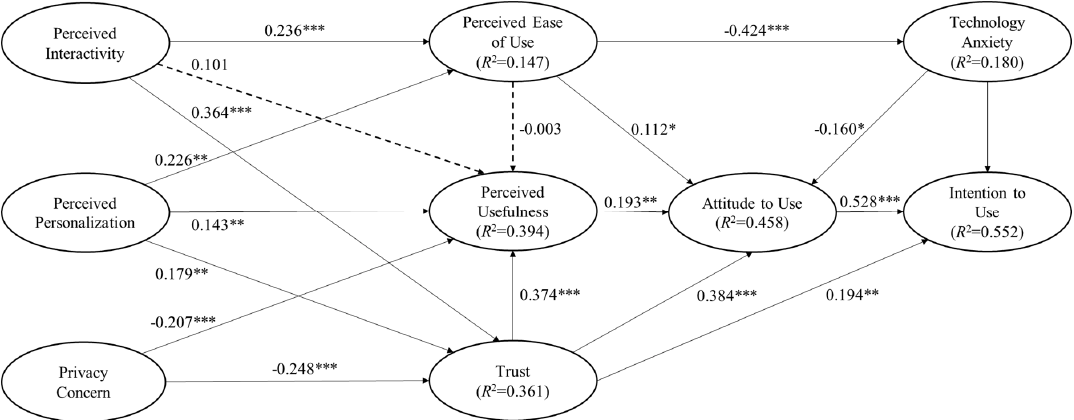
Figure 3. PLS results and significant path coefficients: * p < 0.05, ** p < 0.01, and *** p < 0.001. Table 5. Results of hypothesis testing.